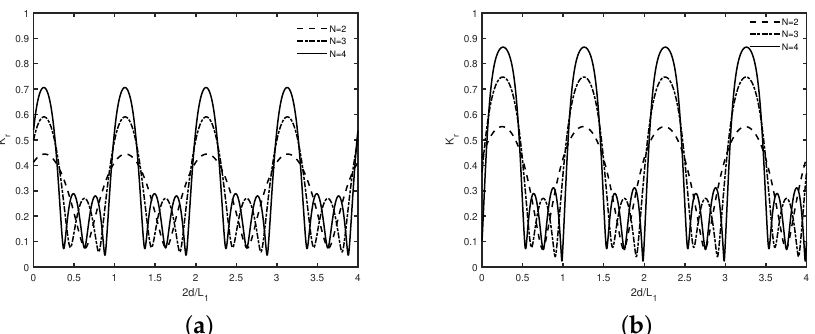
Figure 14. Reflection coefficient K r versus gap 2 d / L 1 for different number of ( a ) trenches with w / L 1 = 0.33; ( b ) breakwaters with w / L 1 = 0.89 in the presence of a semi-infinite plate with D / ρ g = 10 5 m 4 , L g / L 1 = 0.25.